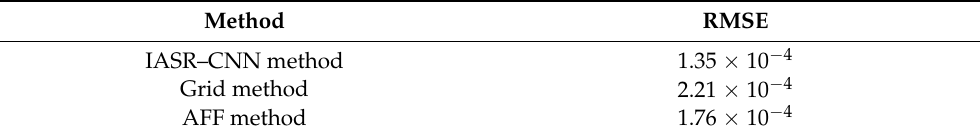
Table 2. The evaluation metrics of the spectrum corresponding to the images reconstructed by three methods.